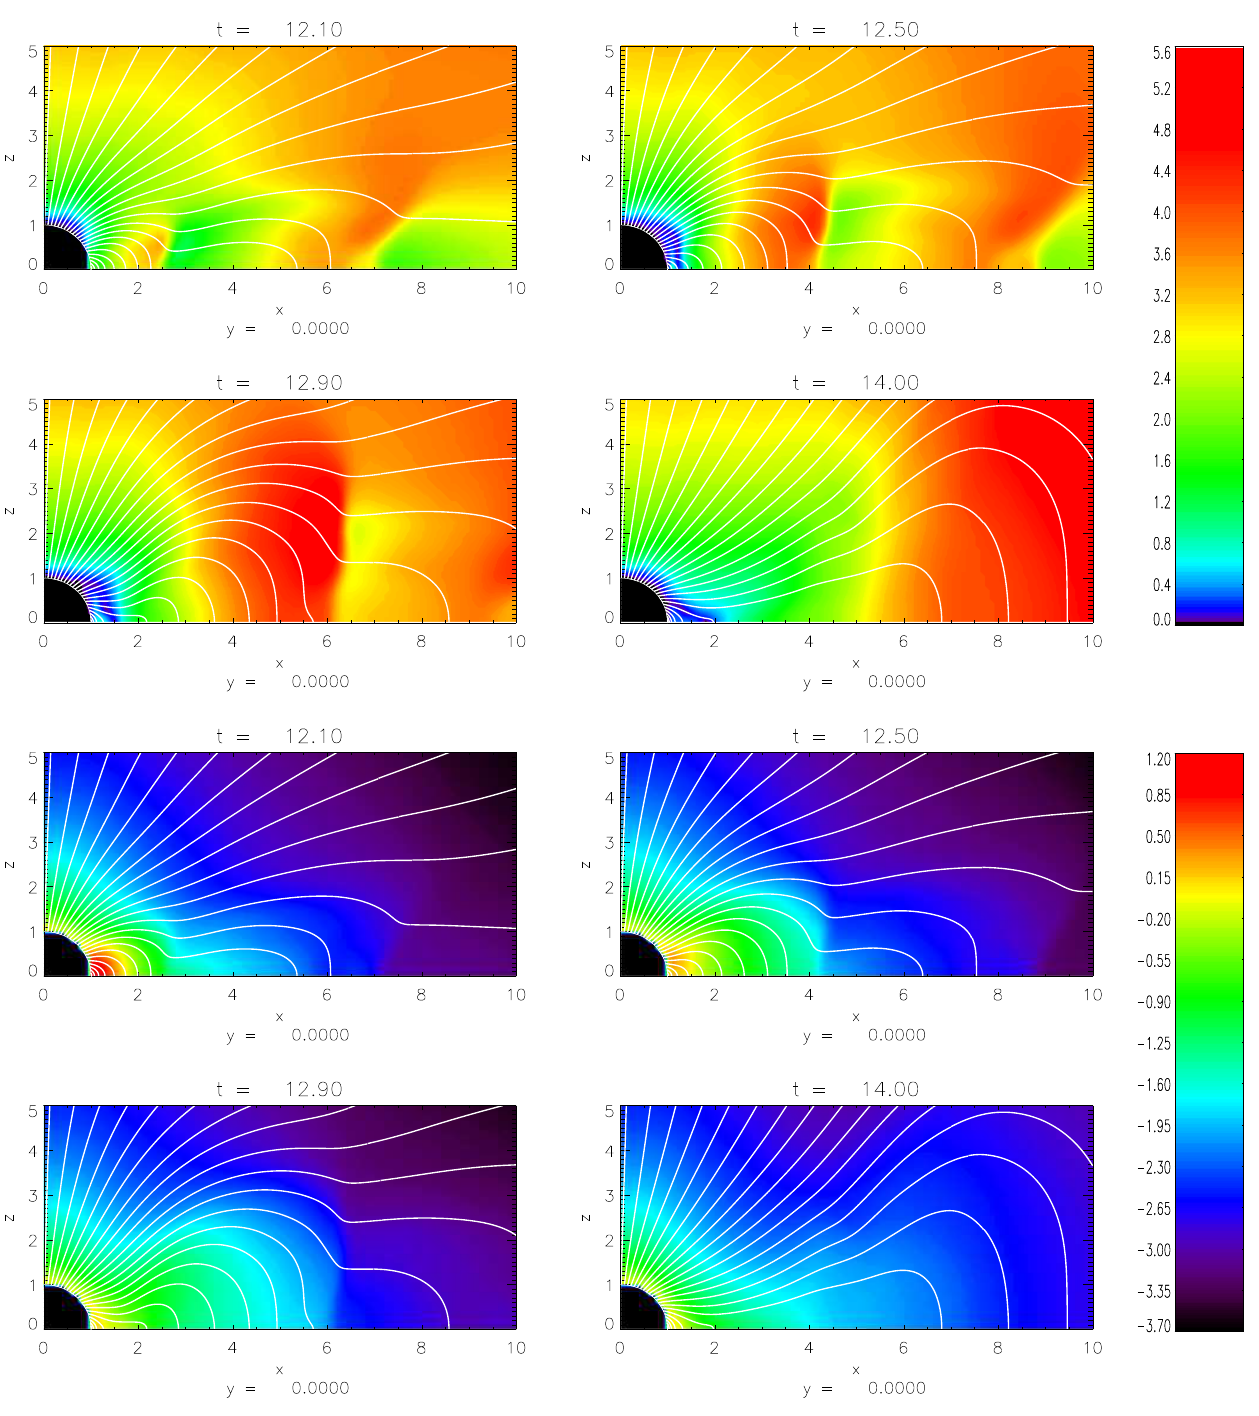
Fig. 9. Selected snapshots from a simulation of two interacting CMEs showing velocity (top) and decadic logarithm of density (bottom), as well as magnetic field lines (white) in the ( y = 0) plane. The initial and final states are practically identical with the corresponding situation shown in the first and last frame of Fig. 6, and are therefore not repeated